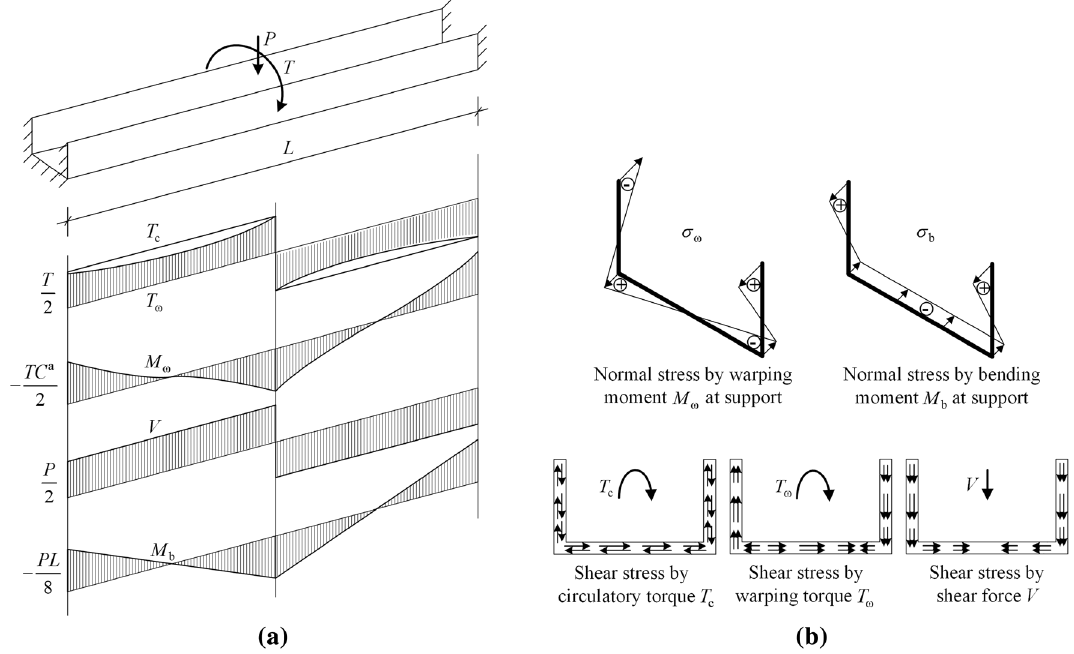
Fig. 3 Internal forces and stress distributions under mixed torsion, shear and flexure. a Distributions of internal forces and b stress distributions induced by internal forces. a C ¼ ½ ch ð a L = 2 Þ (cid:2) 1 (cid:3) = ½ a (cid:4) sh ð a L = 2 Þ(cid:3) ; where a ¼